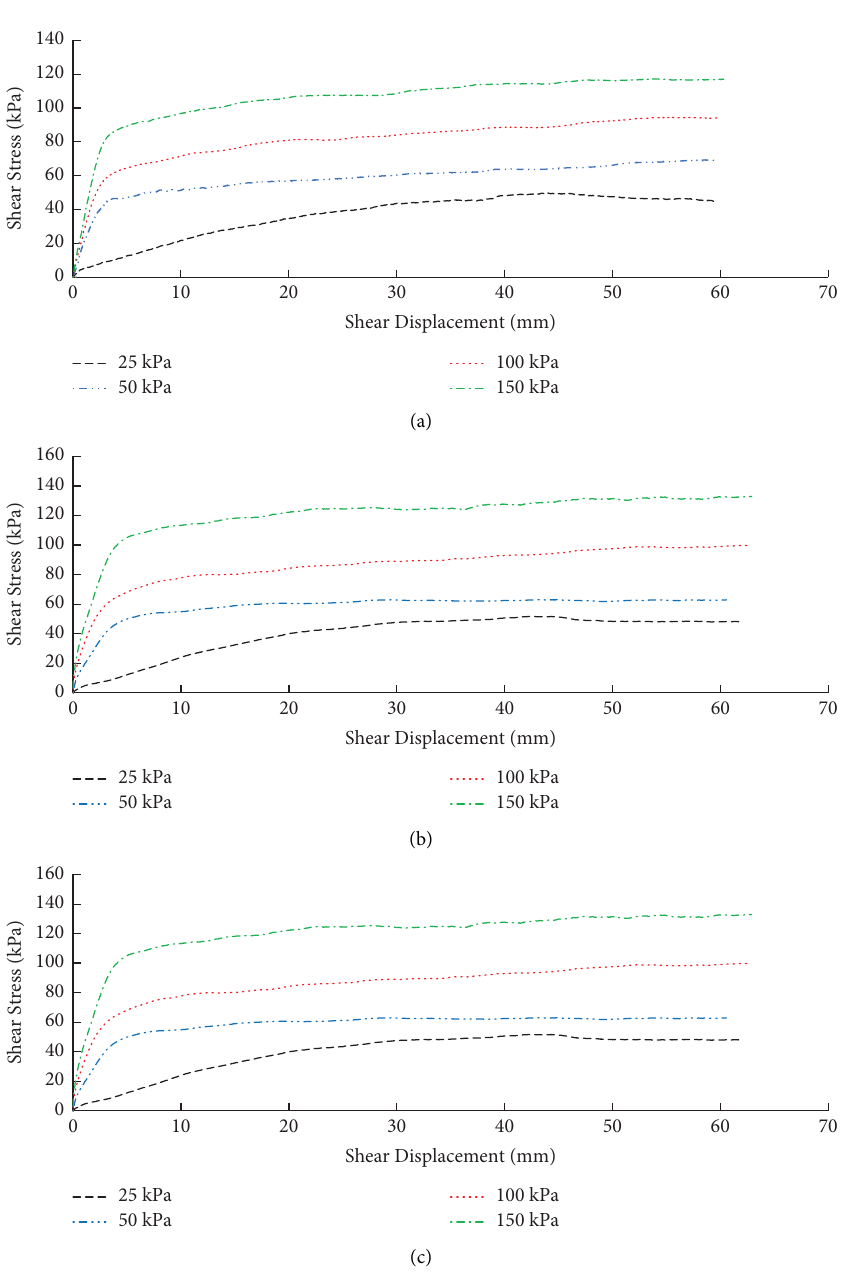
Figure 12: Relationship curve between shear stress and shear displacement under diferent shear rates. (a) Shear rate of 1mm/min. (b) Shear rate of 3 mm/min. (c) Shear rate of